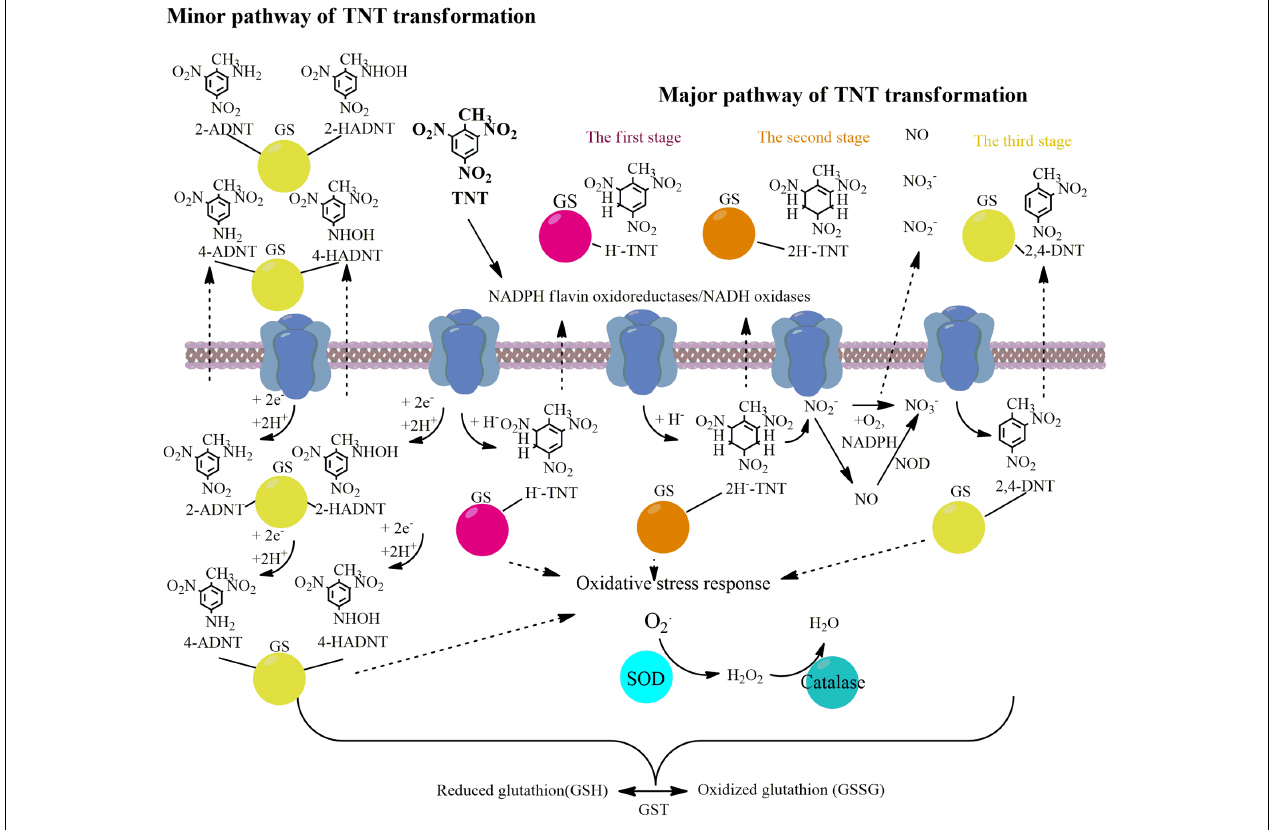
FIGURE 5 | Schema illustrating the main pathways and key upregulated enzymes of TNT transformation by Y. lipolytica